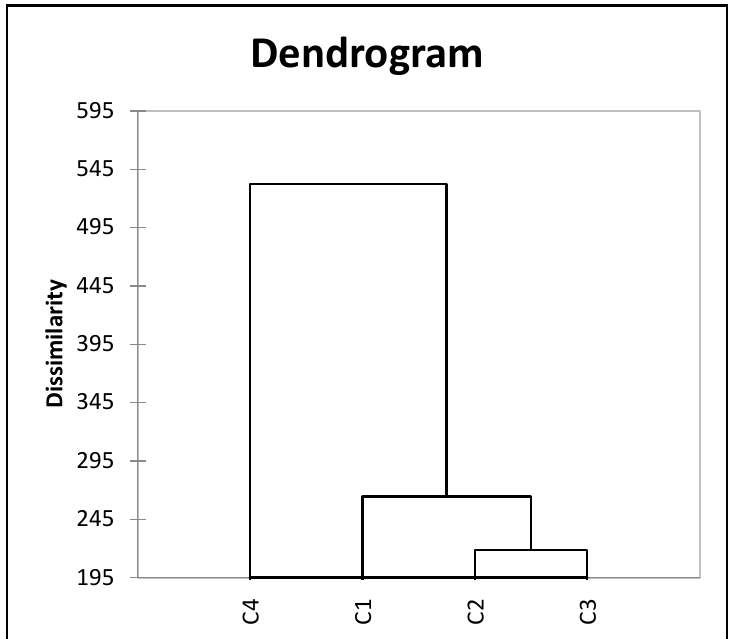
Cluster analysis aids in determining the existing variation among genotypes and